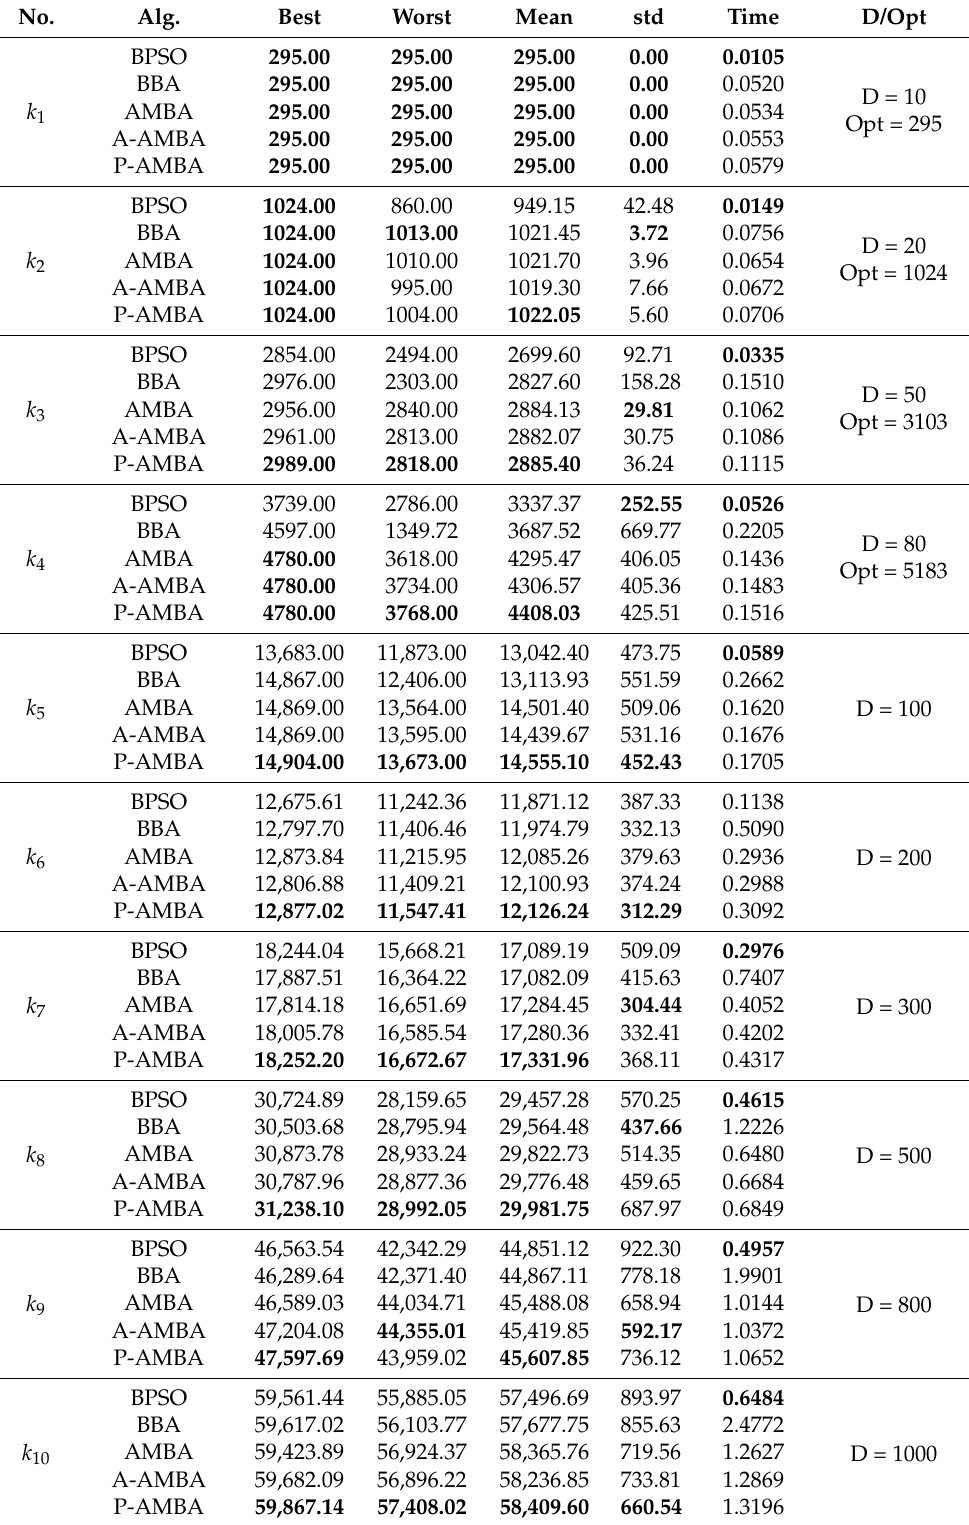
Table 4. Comparison among five algorithms for solving 0–1 knapsack problems with different